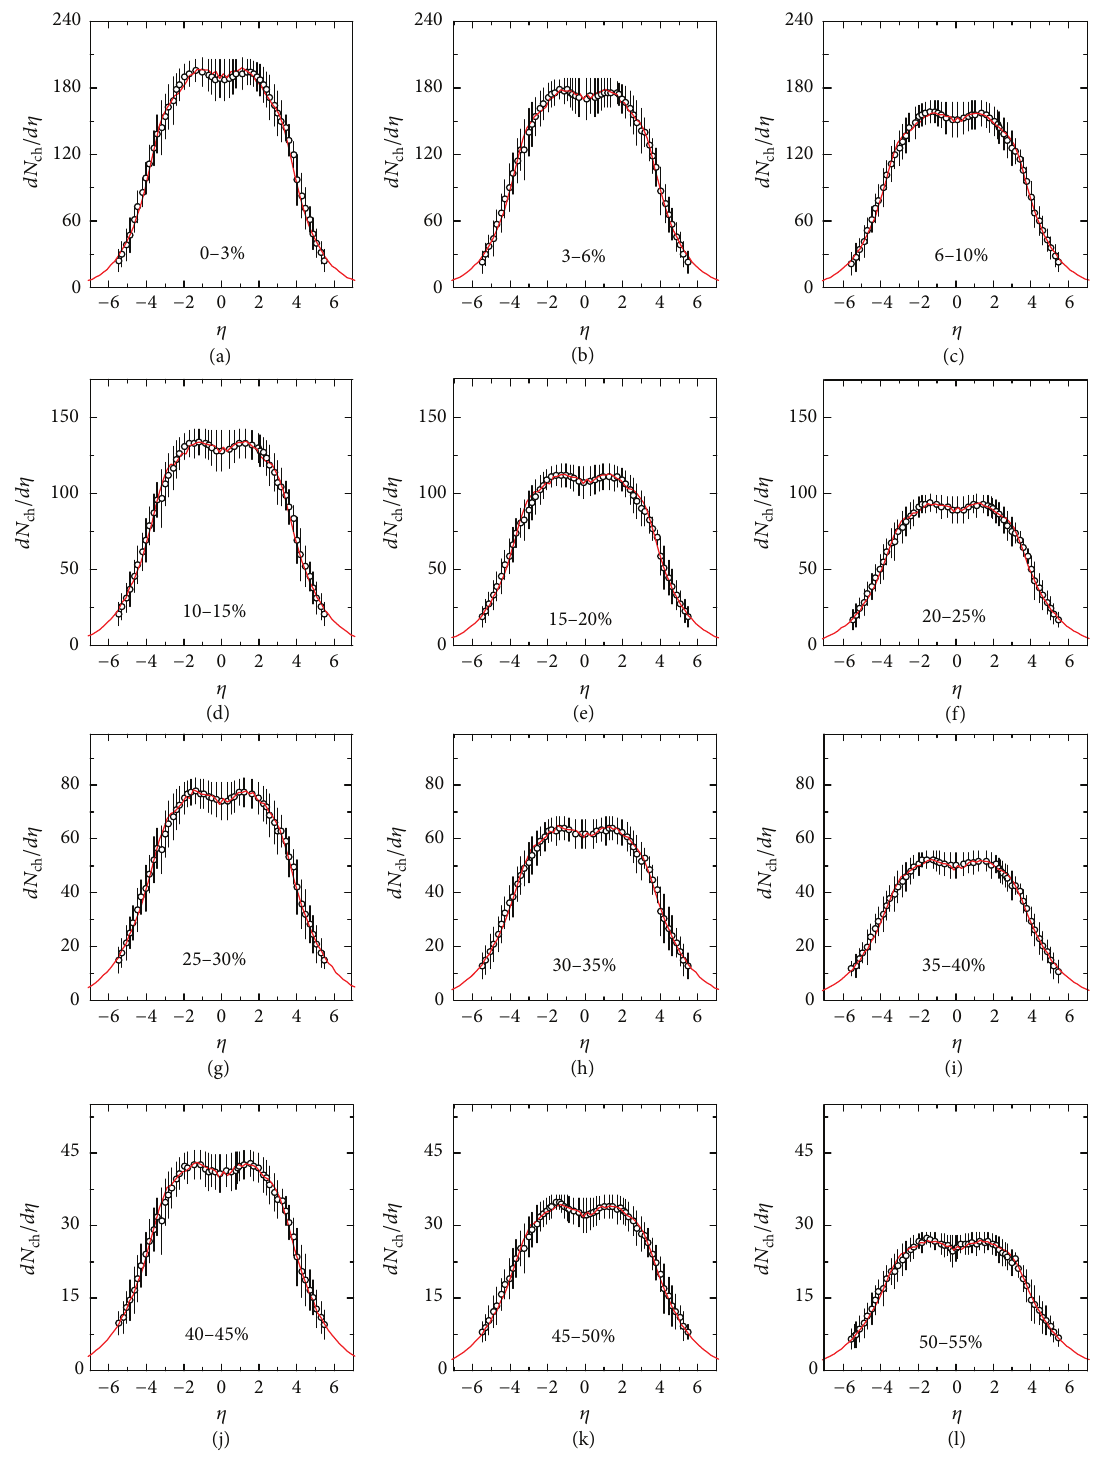
Figure 7: The same as Figure 1 but showing the results of Cu-Cu collisions at √ 𝑠 NN = 200